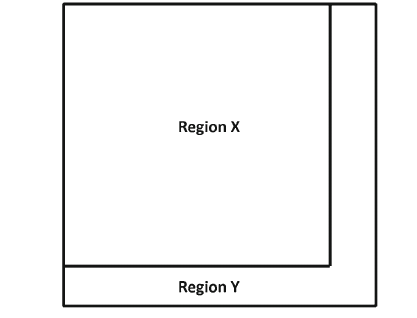
Fig. 3 Cover image